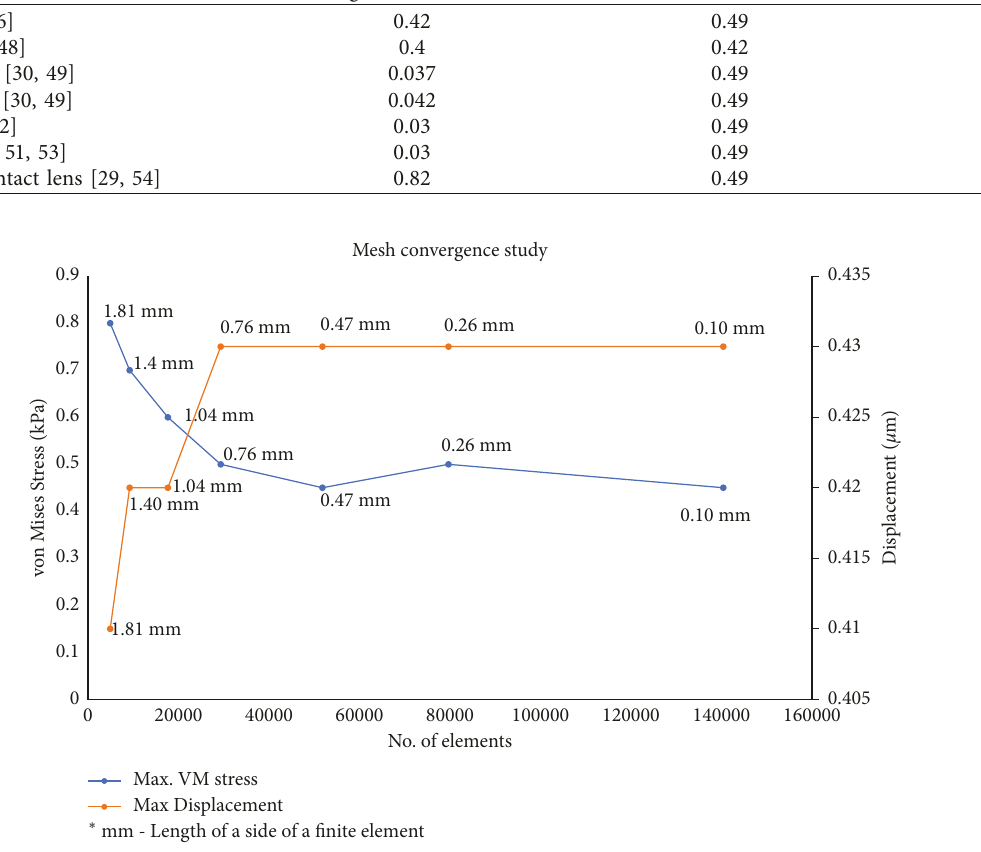
Table 2: Material properties of the ocular structures and contact lens used in the finite element modeling. Part of the eye